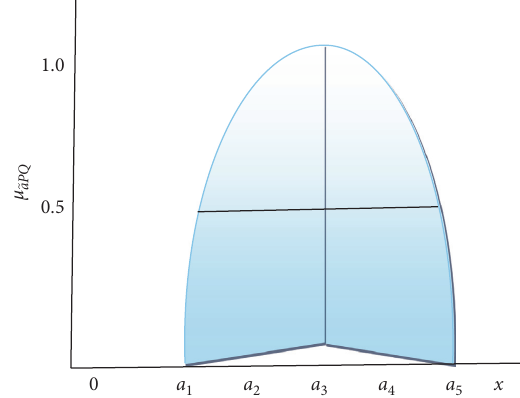
Figure 1: Graphical representation of a piecewise quadratic fuzzy number